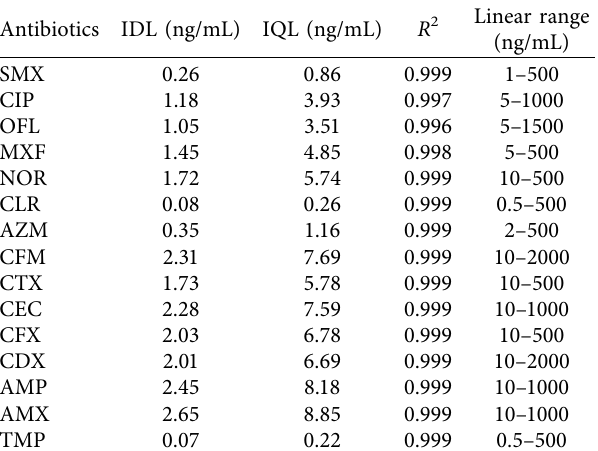
Table 2: Instrument performance and validation